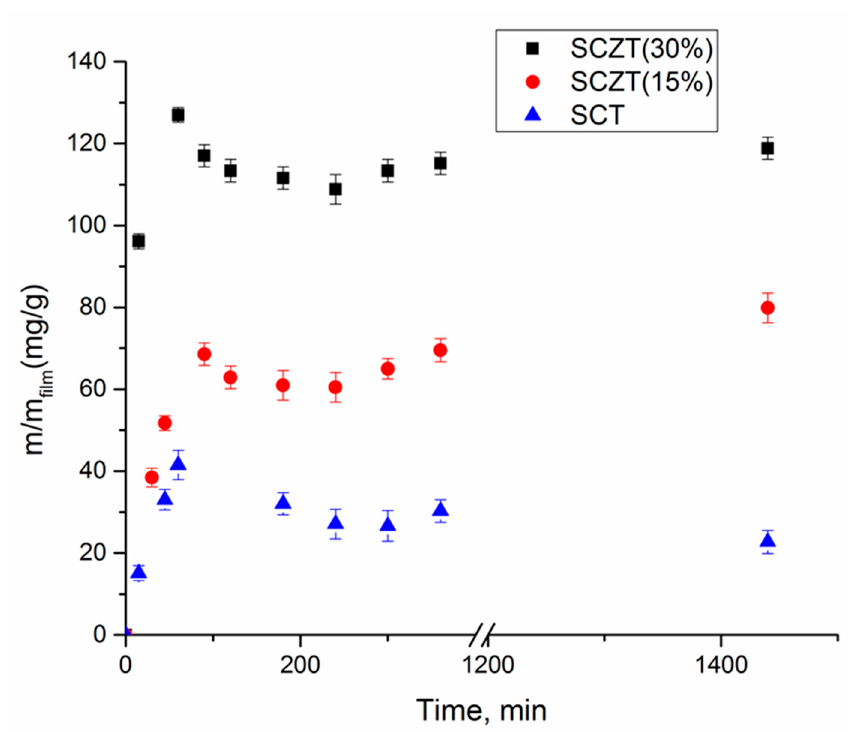
Figure 5. Thymol release kinetics from SCT film with 10.08% of thymol, SCZT (15%) with 16.7% of thymol and SCZT (30%) with 24% of thymol into distilled water.